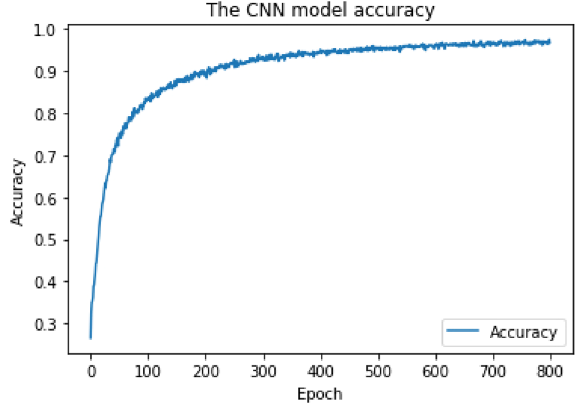
Figure 4. CNN training model achieved 94% accuracy for multiclass classification.